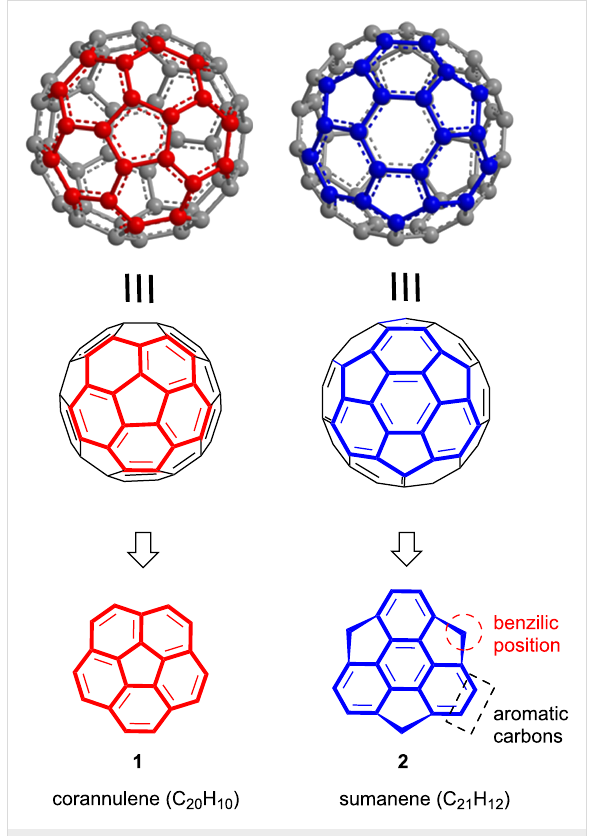
Figure 1: Representation of corannulene ( 1 ) and sumanene ( 2 ), the subunits of fullerene (C 60 ).